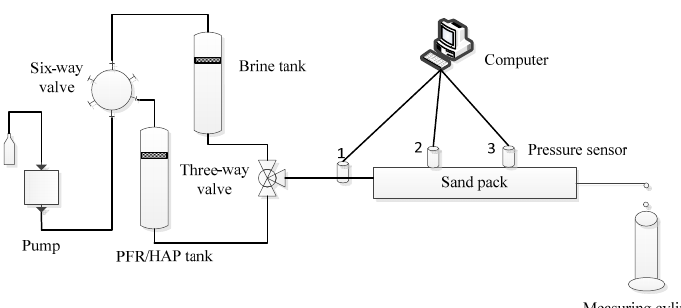
Figure 3. Schematic diagram of flood experiment for a sand pack.